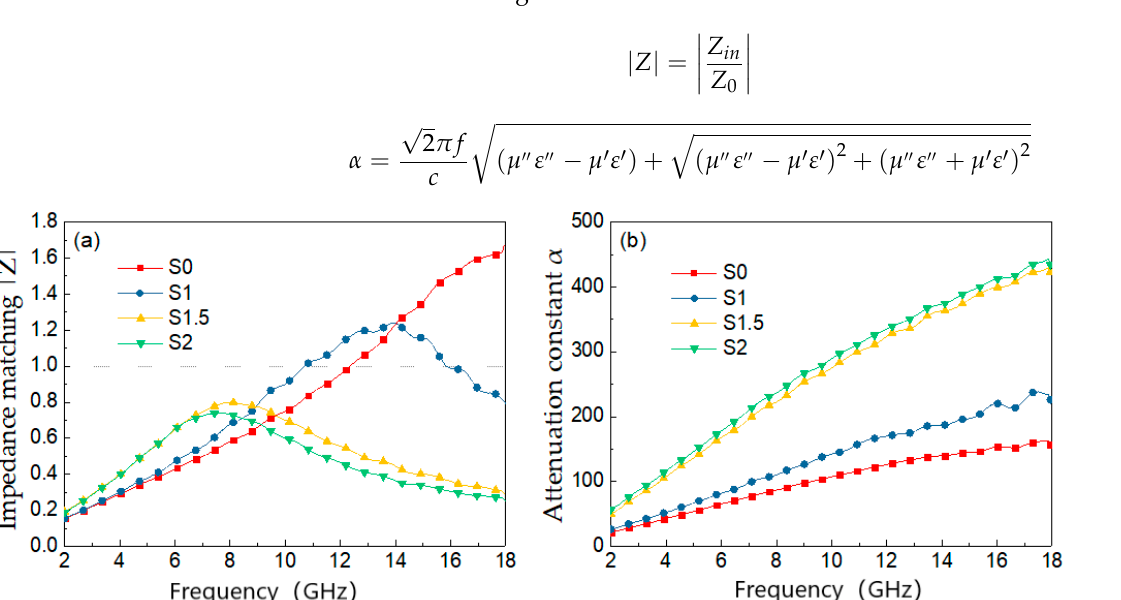
Figure 4. ( a ) Impedance matching ratio; ( b ) attenuation constant.